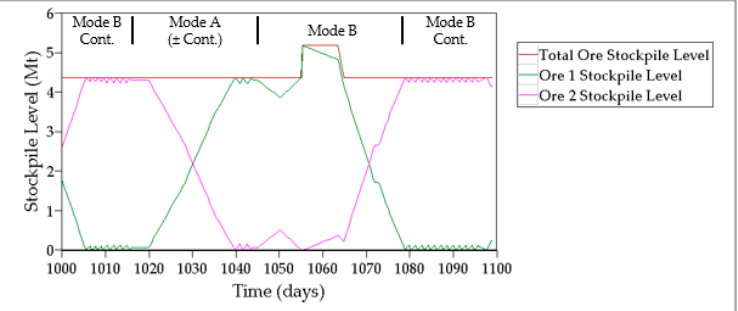
Figure 10. Simulated mining surge caused by high variability of Canadian oil sands data in response to geological uncertainty. Surges are indicated when the level of one of the ore types increases above the total stockpile target and are required to provide feed directly to the plant as recourse to